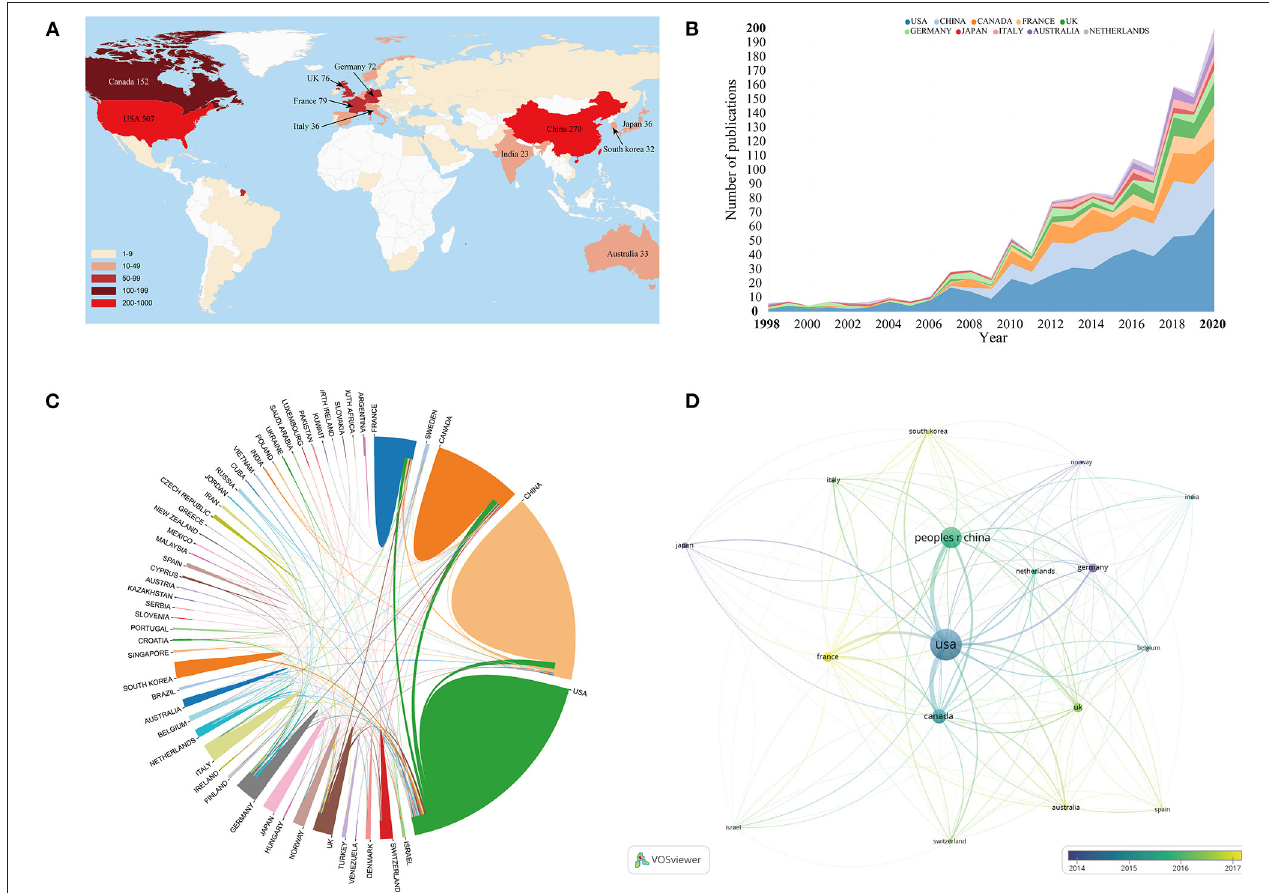
FIGURE 4 | (A) Geographic distribution maps based on the total publications of different countries. (B) The annual number of publications from the top 10 countries between 1998 and 2020. (C) An analysis of international cooperation among countries. (D) Citation network map of countries generated by using VOS viewer